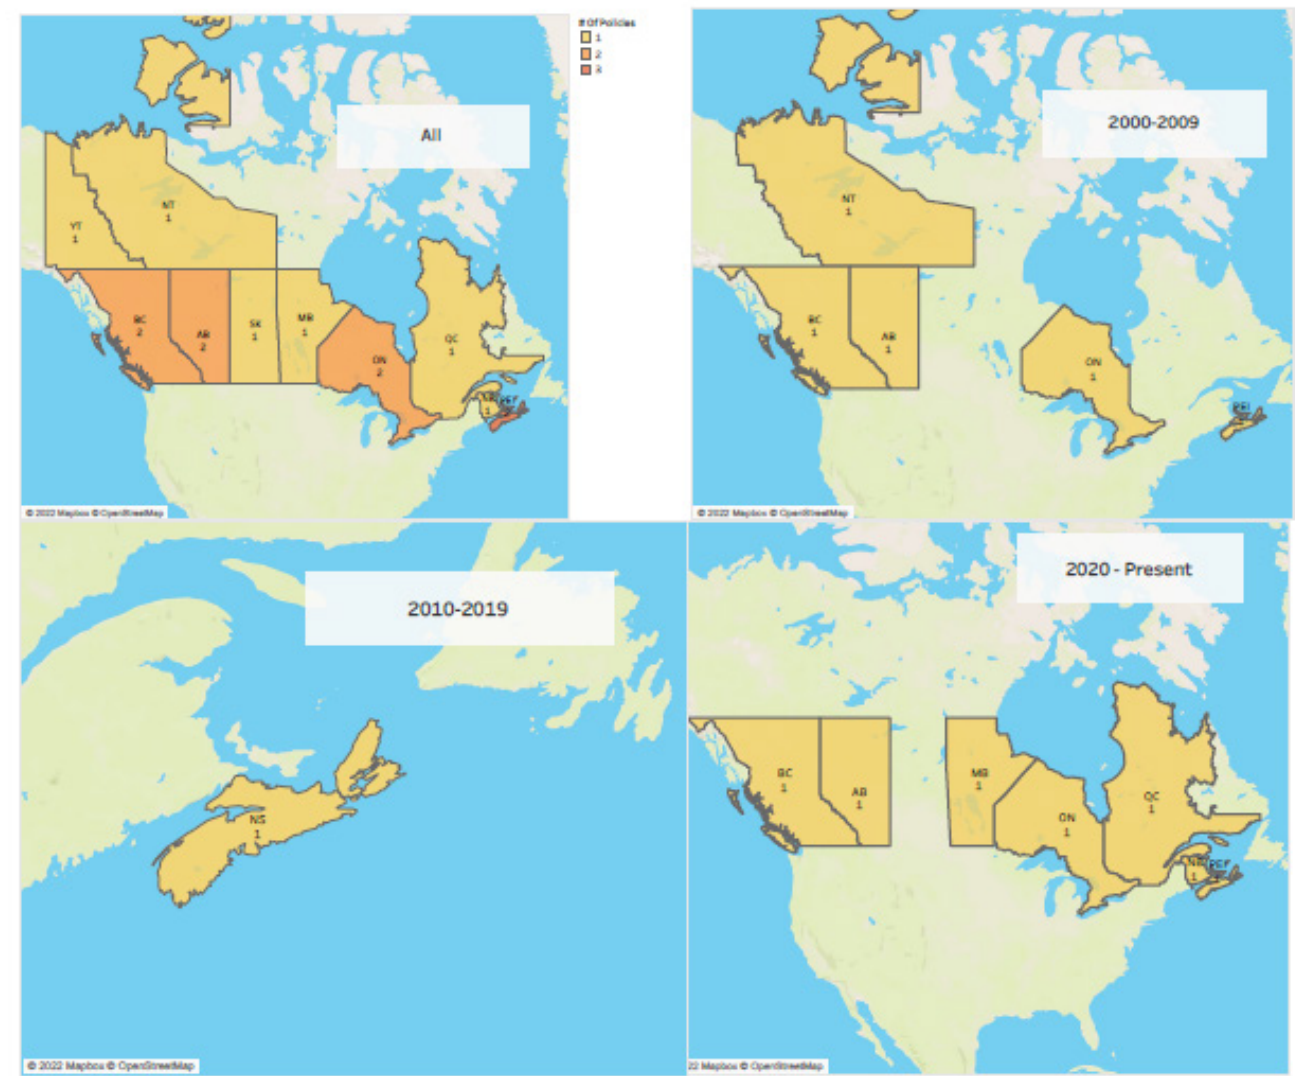
Figure 6: Distribution of actions over time periods in Canada Trends over